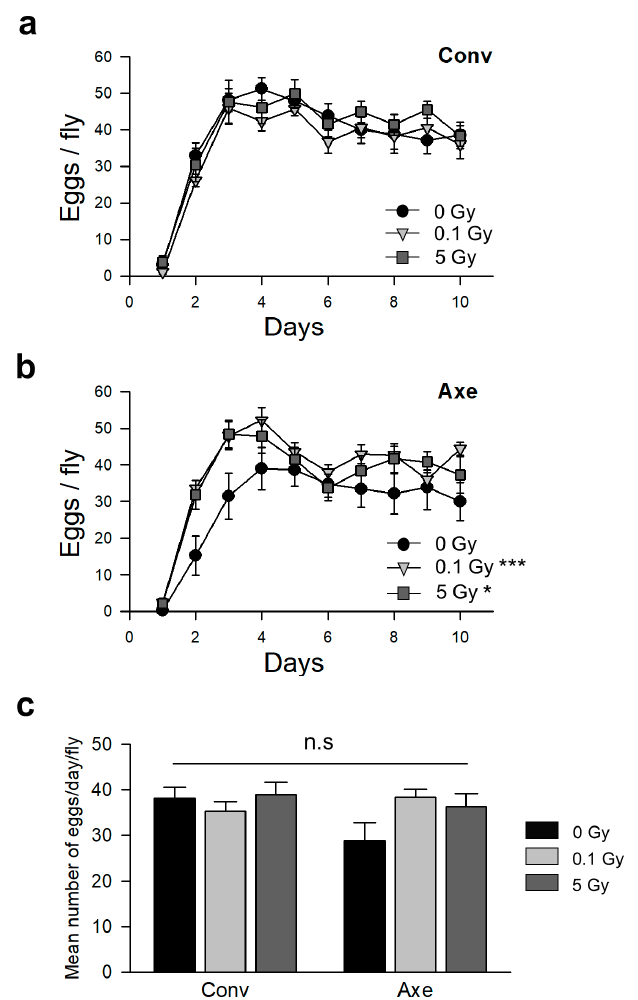
Figure 3. Fecundity of Conv or Axe D. melanogaster after γ -ray irradiation. The number of eggs per fly of the Conv ( a ) or Axe ( b ) flies for 10 days. The line with circles indicates the non-irradiated flies, the line with inverted triangles indicates the 0.1 Gy irradiated flies, and the line with squares indicates the 5 Gy irradiated flies. ( c ) The average number of eggs laid by the Conv or Axe flies after irradiation. The black bars indicate the average number of eggs laid by the non-irradiated flies, the light gray bars indicate the average number of eggs laid by the 0.1 Gy irradiated flies, and the dark gray bars indicate the average number of eggs laid by the 5 Gy irradiated flies. No significant (n.s) differences were detected between the groups. Two-way repeated measures ANOVA with Tukey’s post hoc test, * p < 0.05, *** p < 0.001. The error bars represent the SEM.